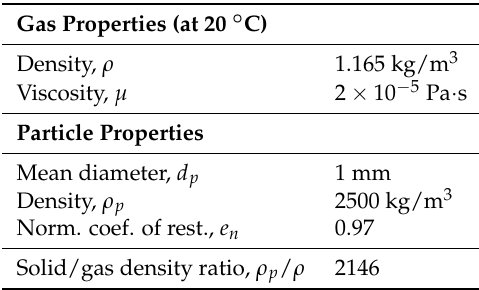
Figure 9. Sketches of the simulated configuration ( left ) and of the intermediate mesh ( right ). Table 1. Gas and particle properties [27].